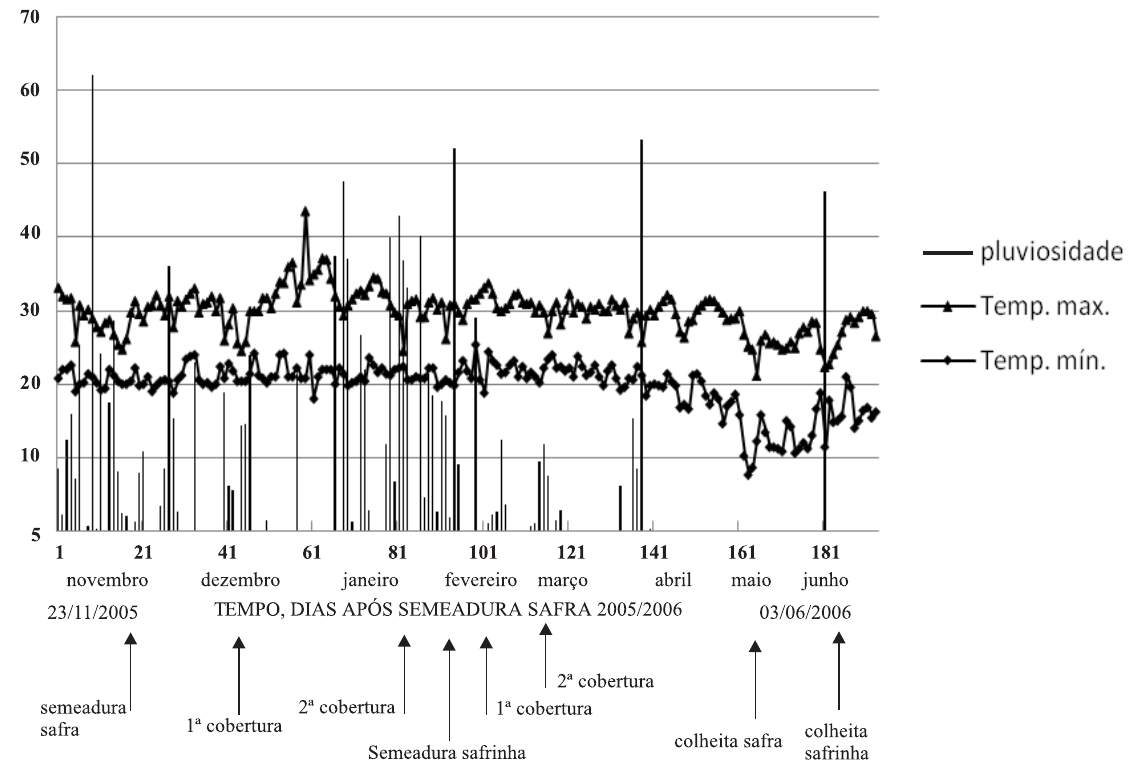
Figura 1. Distribuição da precipitação pluvial entre os meses de novembro de 2005 até início de junho de 2006, incluindo a safra 2005/2006 e safrinha 2006, no Pólo Regional Noroeste Paulista